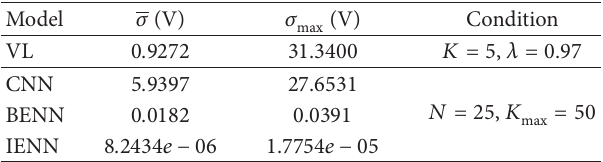
tone signal as input, the simulation results of four behavioral models in time domain are shown in Figure 5. In Figure 5, the time domain error is the transient error y − ̃ y . Values of the mean error 𝜎 and the maximum transient error 𝜎 max of four models are listed in Table 1 with two-tone signal